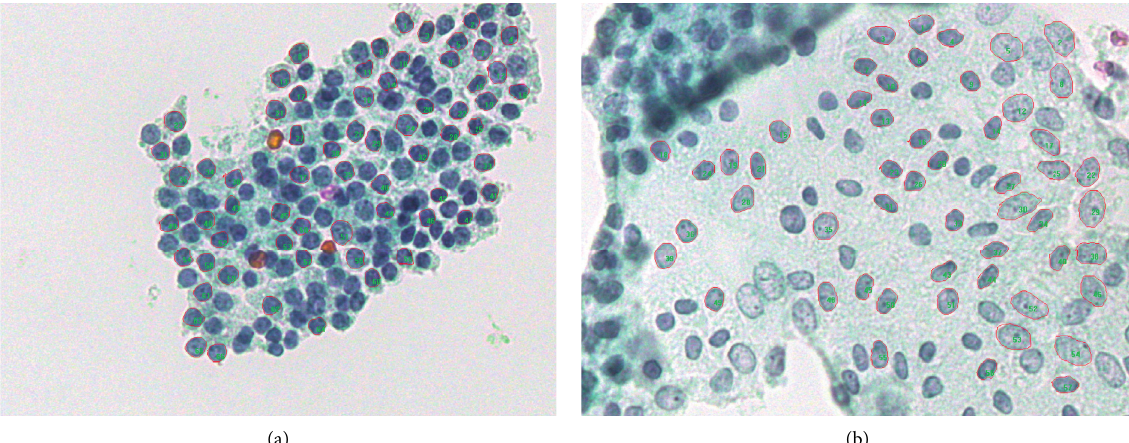
Figure 2: Typical images from the cytological material with highlighted selected nuclei. (a) Image of nodular hyperplasia (benign); (b) image of papillary carcinoma. Both images were captured using a 40x microscope objective